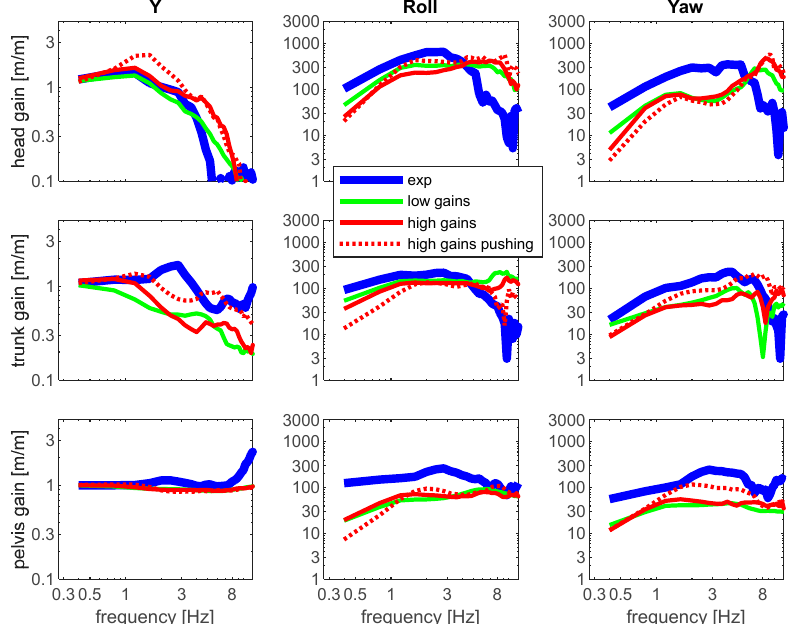
Figure 5. Lateral vibration validation. Model prediction of head ( upper ), trunk ( middle ) and pelvis ( lower ) in translation ( left ) and roll and yaw rotation ( middle and right ). Blue line: experimental; solid green line: best model with low postural gains; red solid line: high gains fitted towards the slalom but no pushing; red dotted line: high gains and with hips and knees pushing the body into the seat back.